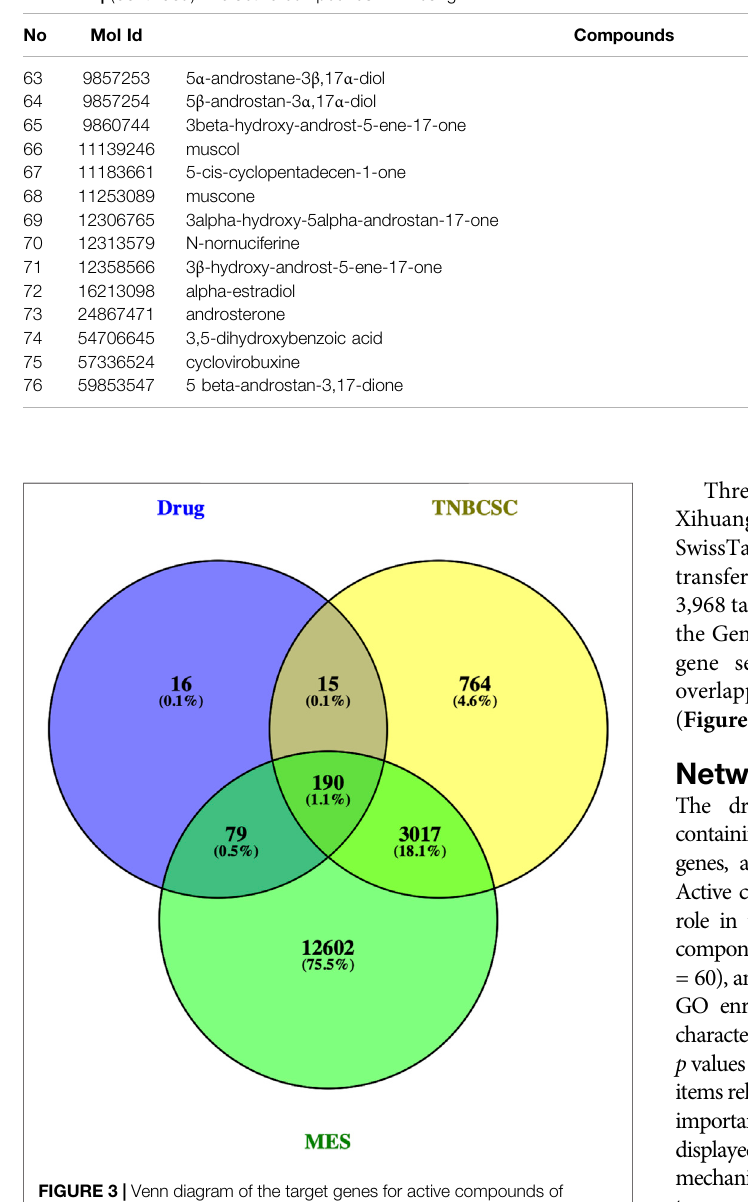
Frontiers in Pharmacology |